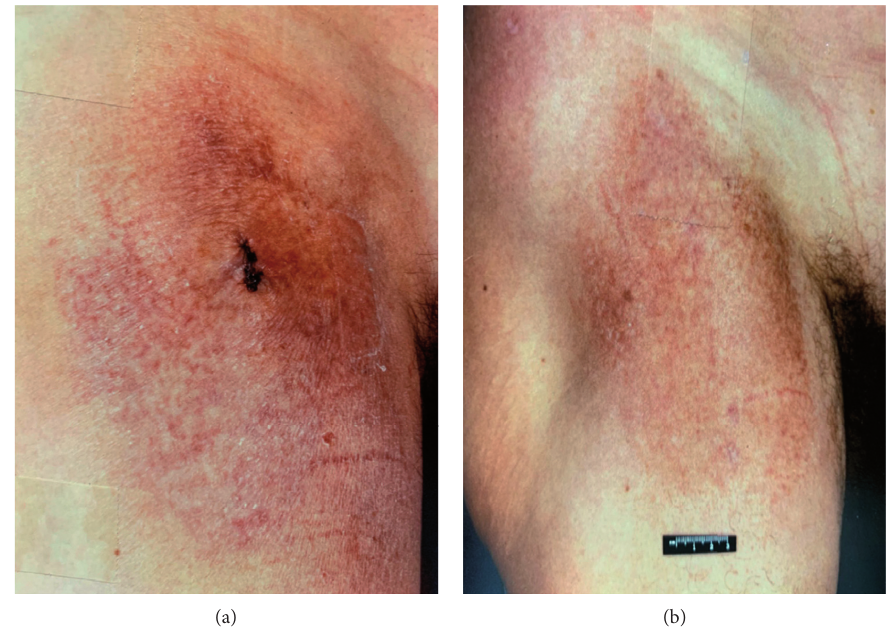
Figure 2: Patient C: clinical images of MF lesion before removal of RCC (a) and 2 years following removal of RCC